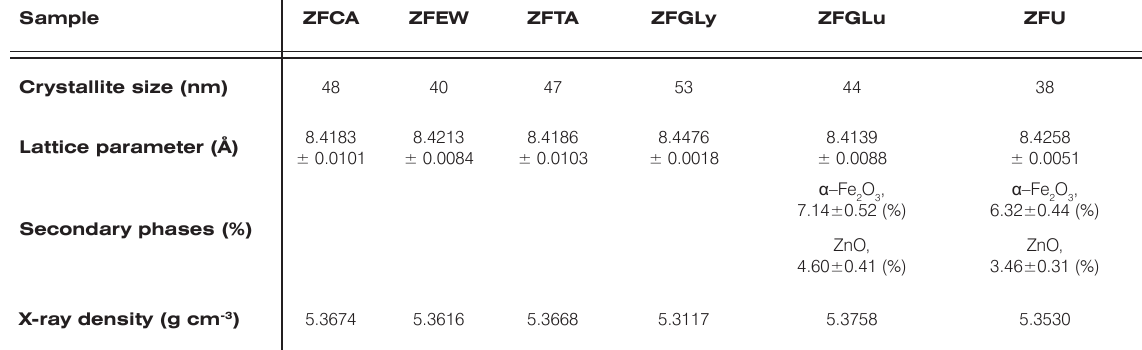
Table 3. XRD data for ZF samples heat treated at 973